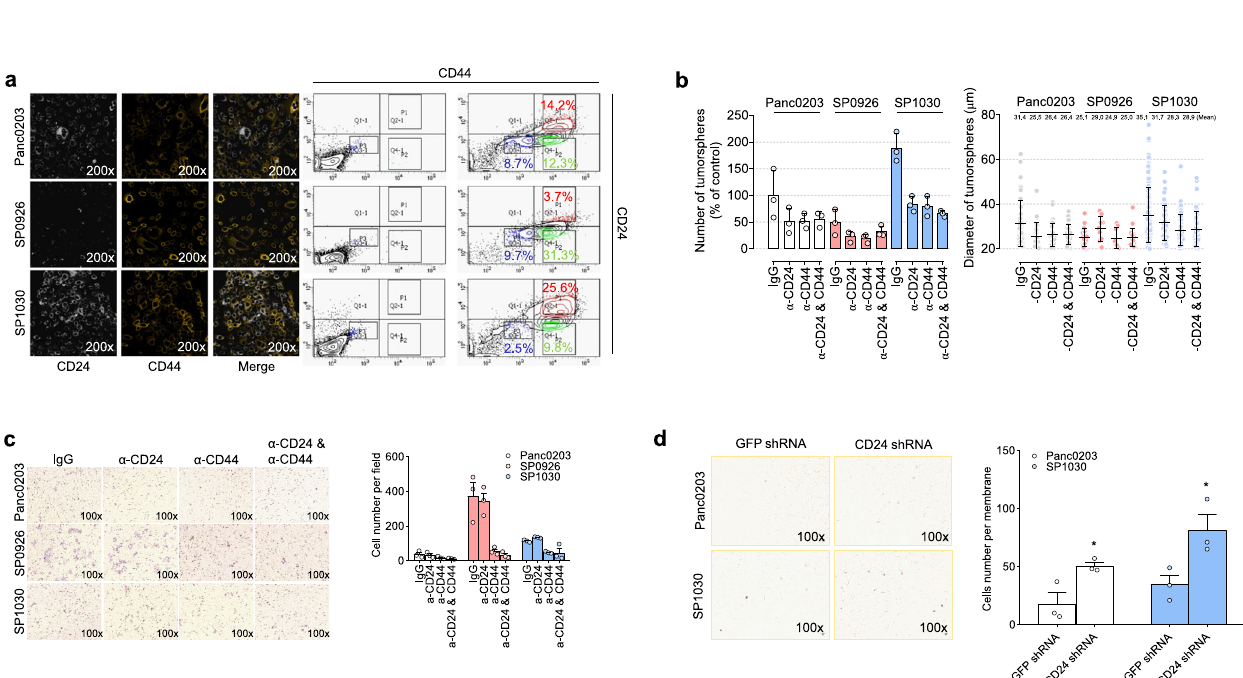
Fig. 4 Regulation of CD24 and CD44 associated with anchorage-independent growth and invasive activities. a Confocal microscopy (left) and fl ow cytometry (right) were performed using speci fi c antibodies for CD24 and CD44 labeled with PE and APC, respectively. b , c Suppression of tumorsphere formation activity ( b ) and invasion activity ( c ) by treatment with either or both of the anti-CD24 and CD44 antibodies. The tumorsphere assay was conducted for 7 days, and the invasion chamber assay system containing Matrigel was performed for 24 h. The relative number of tumorspheres compared to the percentage of Panc0203 cells group treated by IgG control ( b , left). Diameter of tumorspheres ( b , right). d Effect of CD24 short hairpin RNA (shRNA) on the invasion activity of Panc0203 and SP1030 cells. An invasion chamber assay system containing Matrigel was performed for 24 h. Data are presented as the mean values